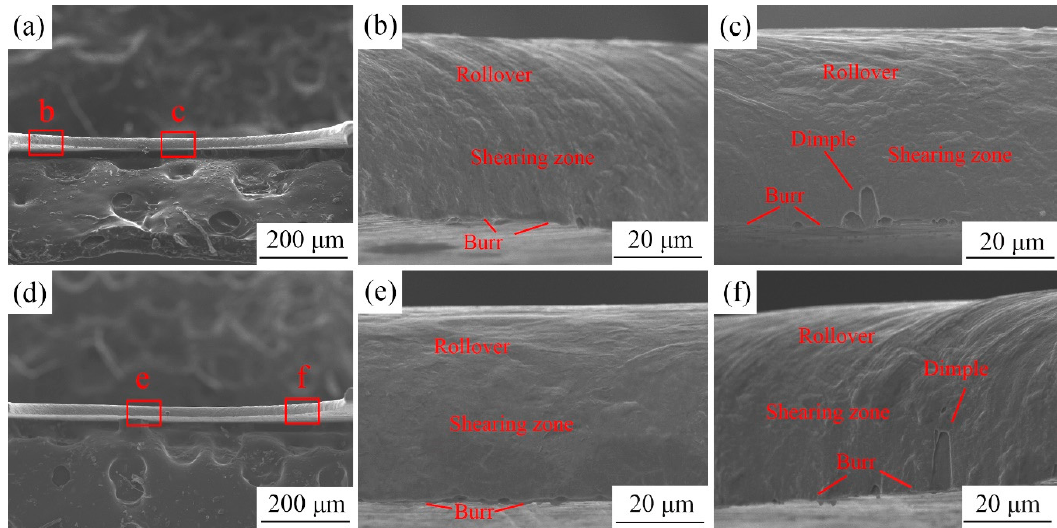
Figure 7. Comparison of the fracture surface of punched parts under a laser energy density of 28.3 J/cm 2 . ( a ) The punched part without LPS; ( b ) and ( c ) respectively correspond to the regions “b”, “c” in ( a ); ( d ) the punched part with LPS; ( e ) and ( f ) respectively correspond to the regions “e”, “f” in ( d ).